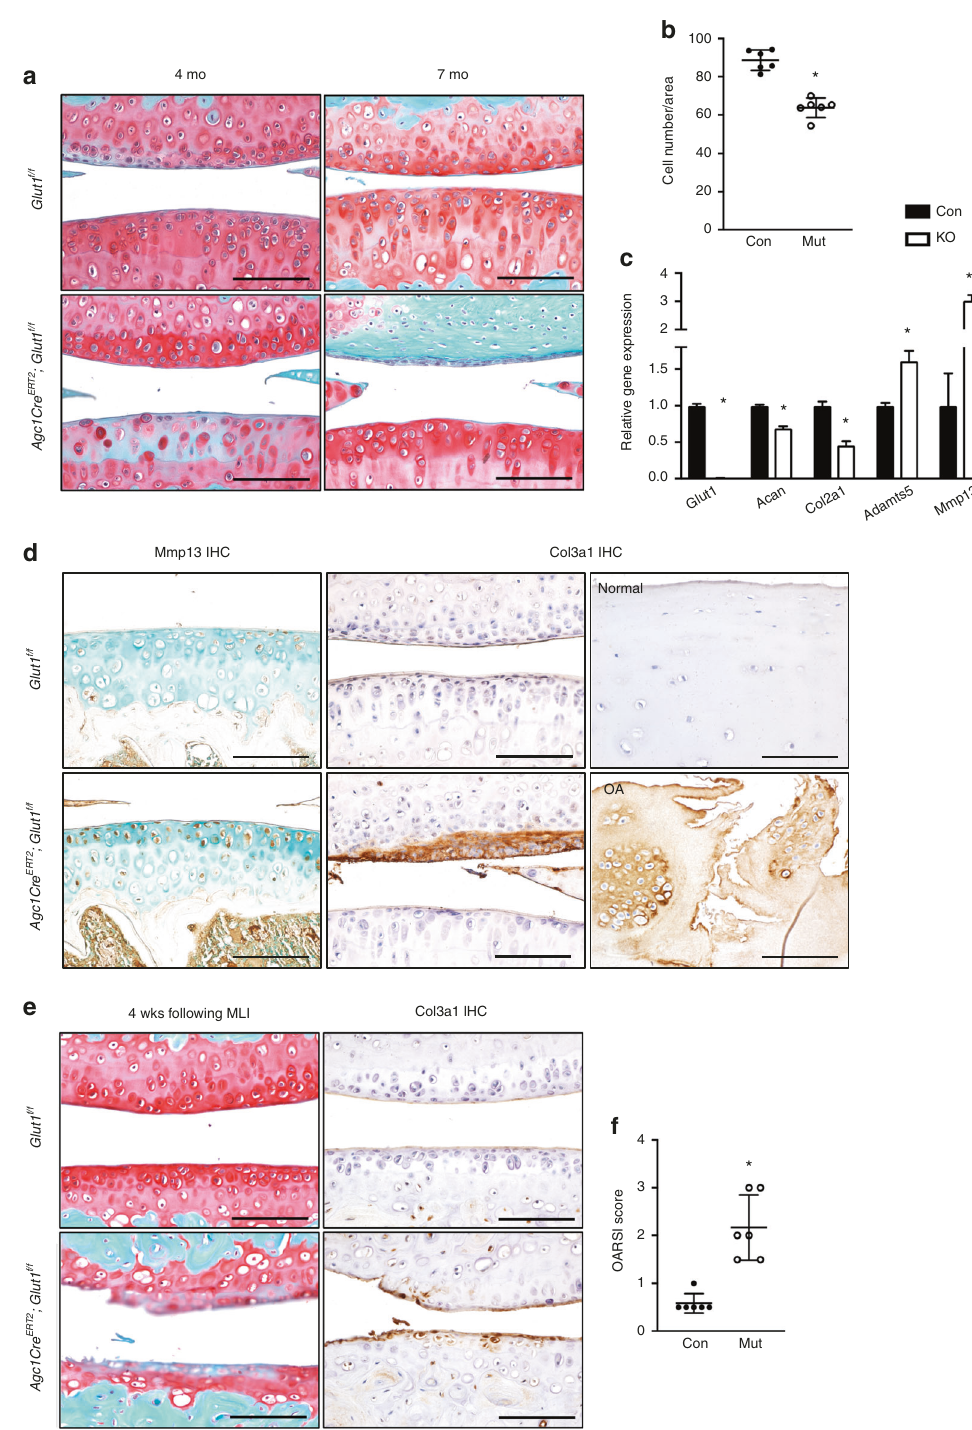
Fig. 4 Deletion of Glut1 in chondrocytes decreases cellularity, disrupts cellular homeostasis, and ultimately causes cartilage fi brosis in AC. a Safranin O/Fast Green staining of knee sections of control and Glut1 LOF mice at 4 months and 7 months. N = 6. Scale bar, 100 μ m. b Histomorphometric analyses of chondrocyte numbers in knee sections at 4 months. The data are the mean ± SD. N = 6. * P < 0.05. c RT-qPCR analyses for Glut1 , Col2a1 , Acan , Adamts5 and Mmp13 in control and Glut1 KO primary AC chondrocytes. All mRNA abundances were normalized to that of β -actin and then normalized to those of the controls. The data are the mean ± SD. N = 3. * P < 0.05 relative to the controls. d Immunostaining for Mmp13 and Col3a1 in knee sections of control and Glut1 LOF mice at 4 months ( N = 6) or of Col3a1 in biopsies of normal and osteoarthritic cartilage from human patients ( N = 3). Scale bar, 100 μ m. e Safranin O/Fast Green staining and Col3a1 immunostaining of knee sections of control and Glut1 LOF mice at 4 weeks following MLI injury. N = 6. Scale bar, 100 μ m. f OARSI scores for the medial tibial plateau and femoral condyle at 4 weeks following MLI injury. The data are the mean ± SD. N = 6. * P < 0.05 compared to the